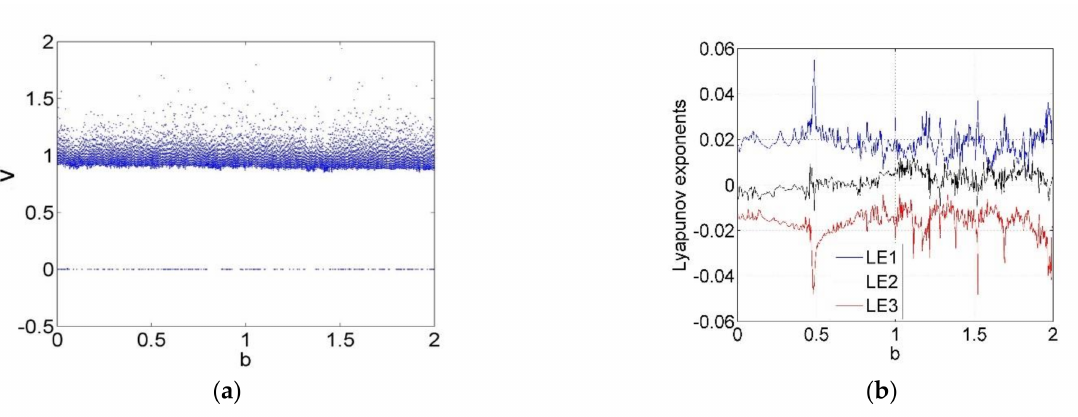
Figure 6. Dynamic study of the chaotic system (4) with ( a , c ) = ( 14,1.4 ) : ( a ) The bifurcation diagram with respect to b and ( b ) The Lyapunov exponents spectrum. Figure 6 signifies robust chaos in the system (4) in the whole bifurcation region.